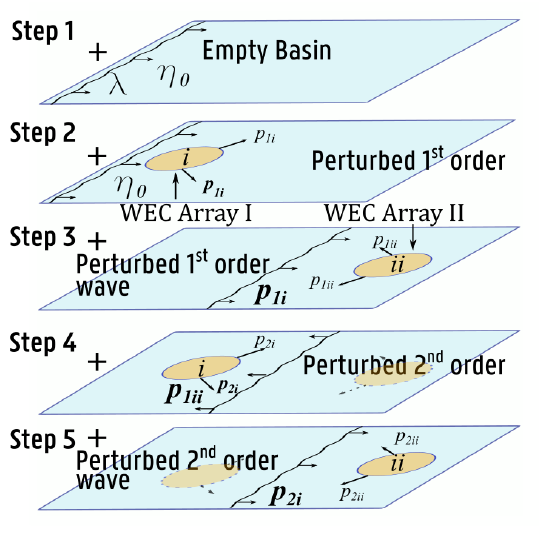
Figure 3. Procedure for determining the perturbed wave field for a regular wave input. Incident wave λ is coming from the